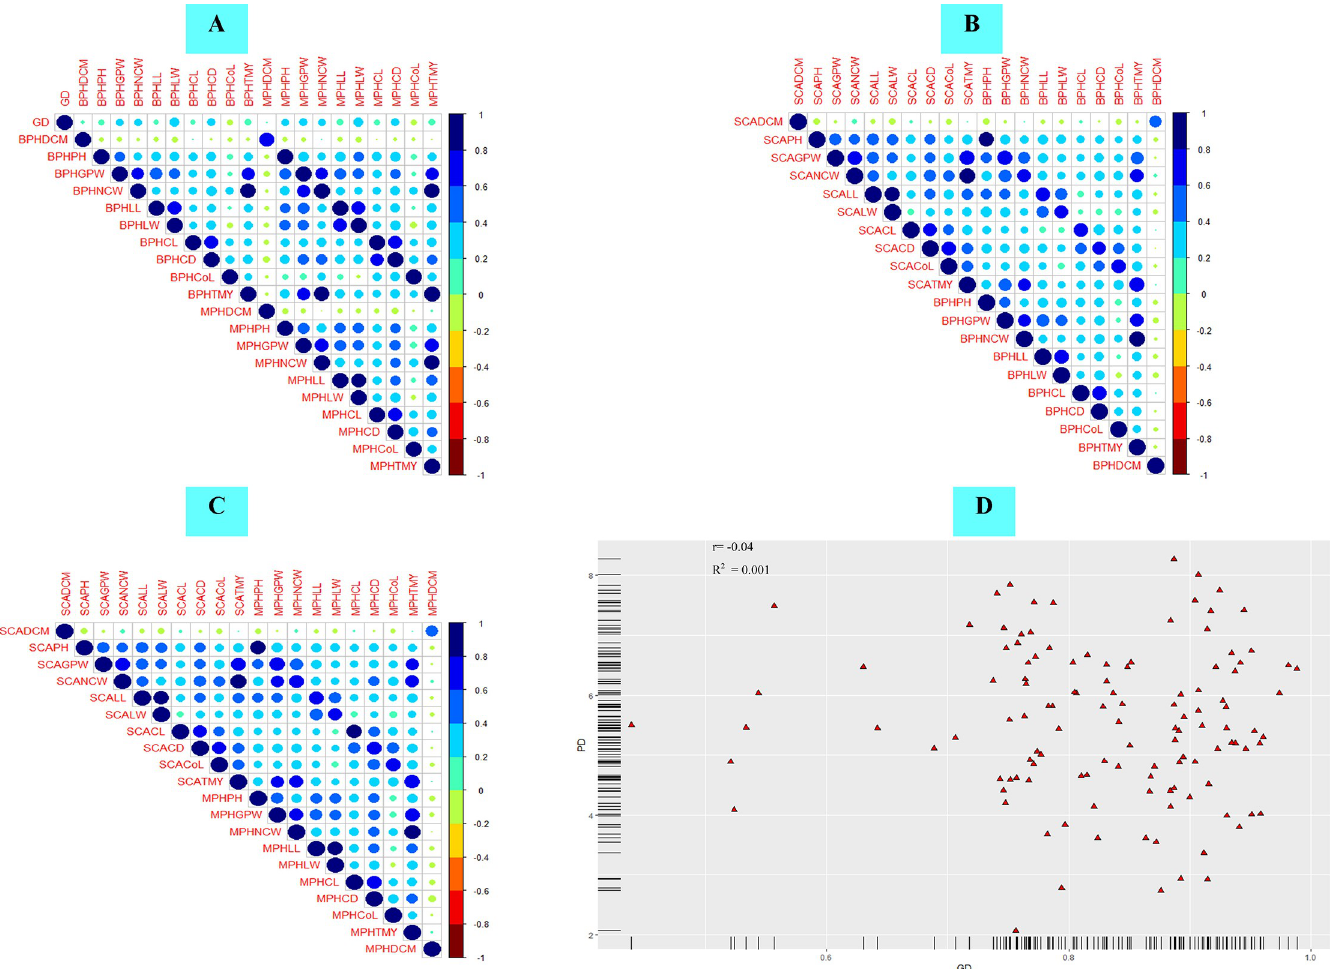
Fig 3. Pearson’s correlation matrix depicting association among genetic distances and heterosis. (A) Corrplot depicting pearson’s correlation coefficient of genetic distance based on molecular data with better-parent heterosis (BPH) and mid-parent heterosis (MPH) for 10 commercial traits, (B) Corrplot depicting pearson’s correlation coefficient of specific combining ability with BPH (C) Corrplot depicting pearson’s correlation coefficient of specific combining ability with MPH (D) Scatter plot depicting no correlation between genetic distance based on molecular data and phenotypic distance. GD is on X-axis and PD on